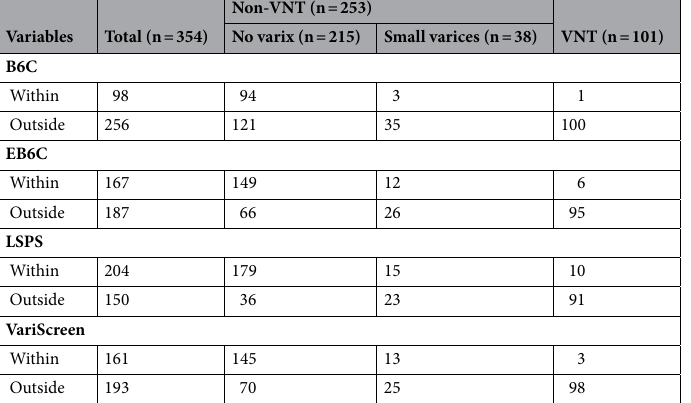
Table 2. Number of non-VNT and VNT generated by the NITs in patients with cACLD. NITs, non-invasive tests; VNT, varices needing treatment; cACLD, compensated advanced chronic liver disease; B6C, Baveno VI criteria; EB6C, Expanded Baveno VI criteria; LSPS, liver stiffness-spleen diameter to platelet ratio risk